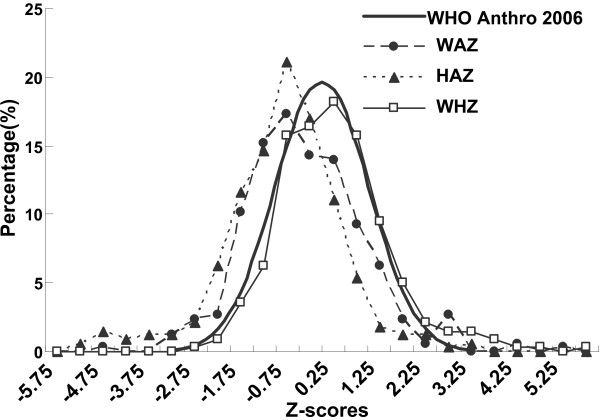
Height for age, Weight for age and Weight for height Z-scores* for 0–18 month-old infants in rural Shaanxi province, China, 2010. *Weight-for-age Z-score (WAZ), height-for-age Z-score (HAZ), and weight-for-length Z-score (WHZ) was calculated with 2006 WHO Anthro and WHO Child Growth Standards [WHO, 2006].